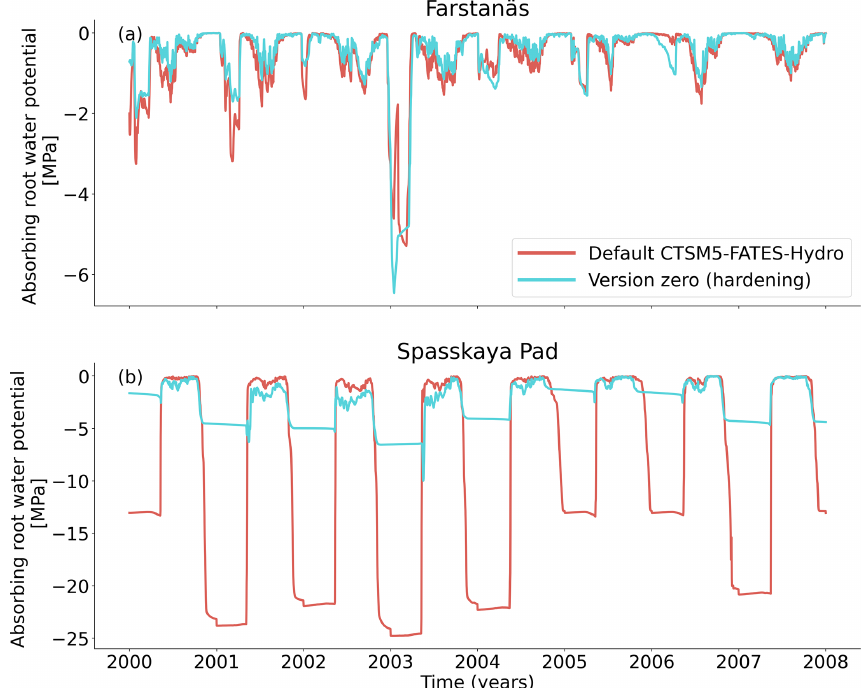
Figure 7. Absorbing root water potential for needleleaf evergreen trees at the sites of (a) Farstanäs and (b) Spasskaya Pad during the period 2000–2008. The default simulation is shown in red, and the hardening simulation is shown in blue.